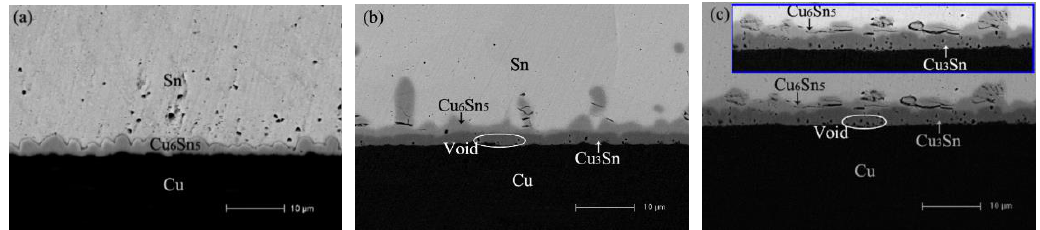
Figure 2. Interfacial microstructure of Sn/EP Cu joints after aging at 150 °C for ( a ) 0 h, ( b ) 240 h, and ( c ) 480 h.